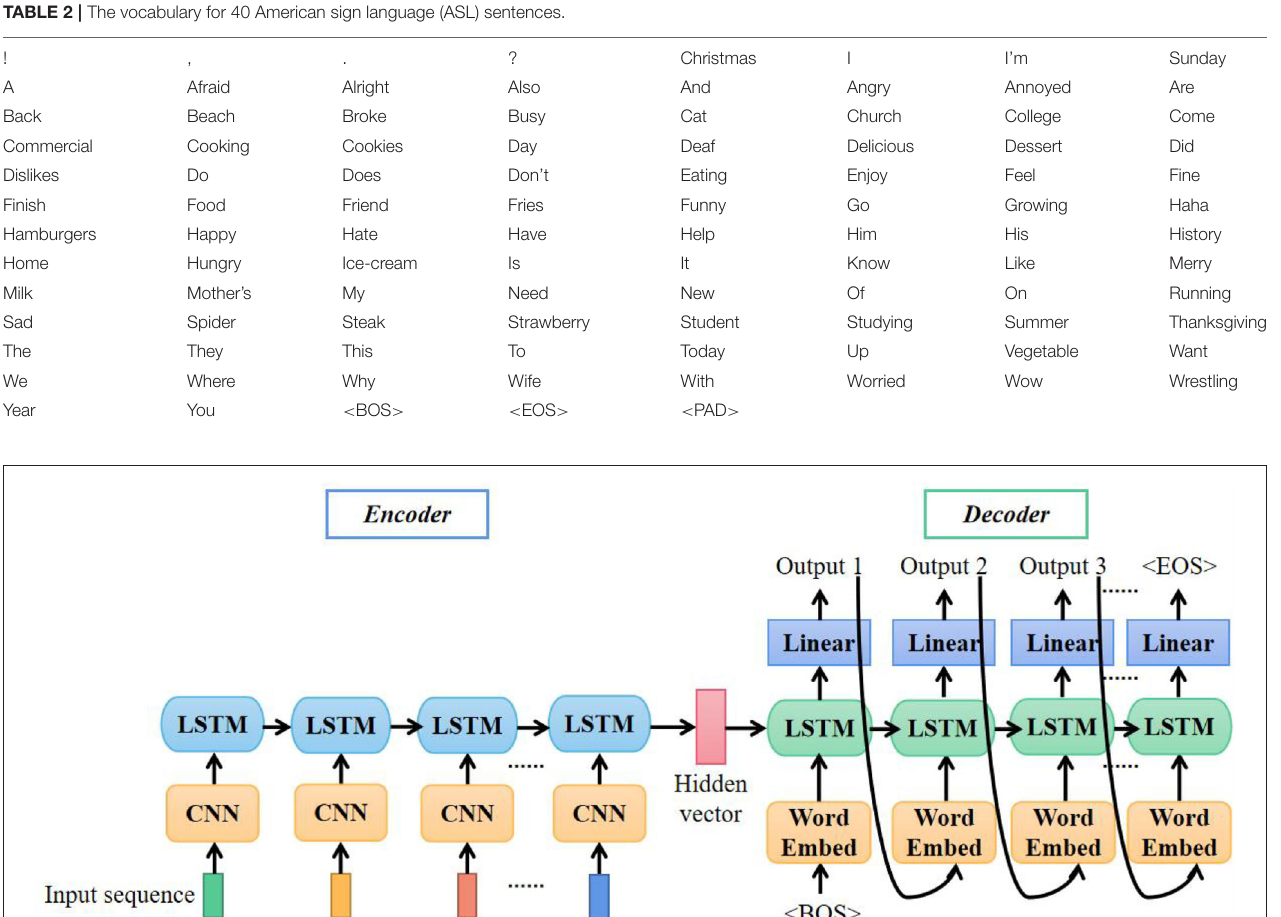
TABLE 2 | The vocabulary for 40 American sign language (ASL) sentences.